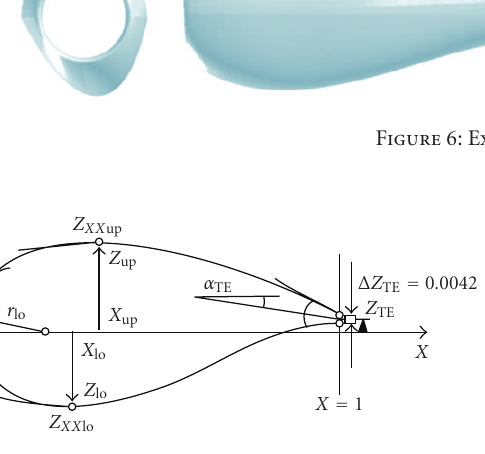
Figure 7: PARSEC airfoil